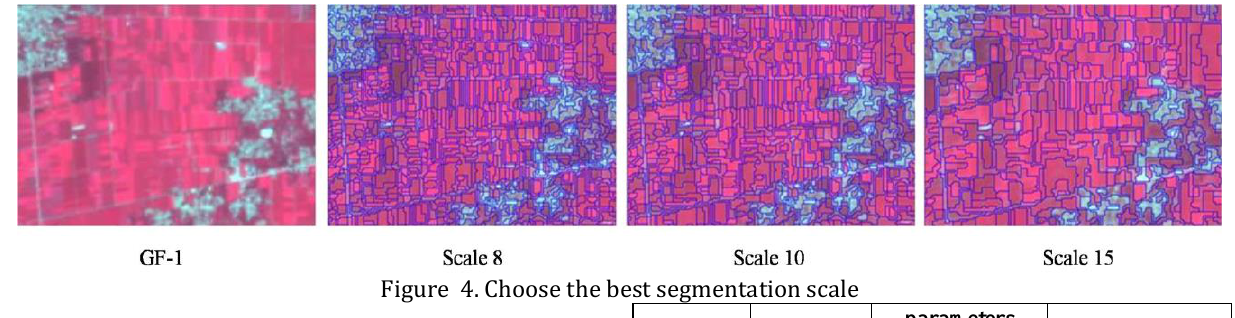
Figure 4. Choose the best segmentation